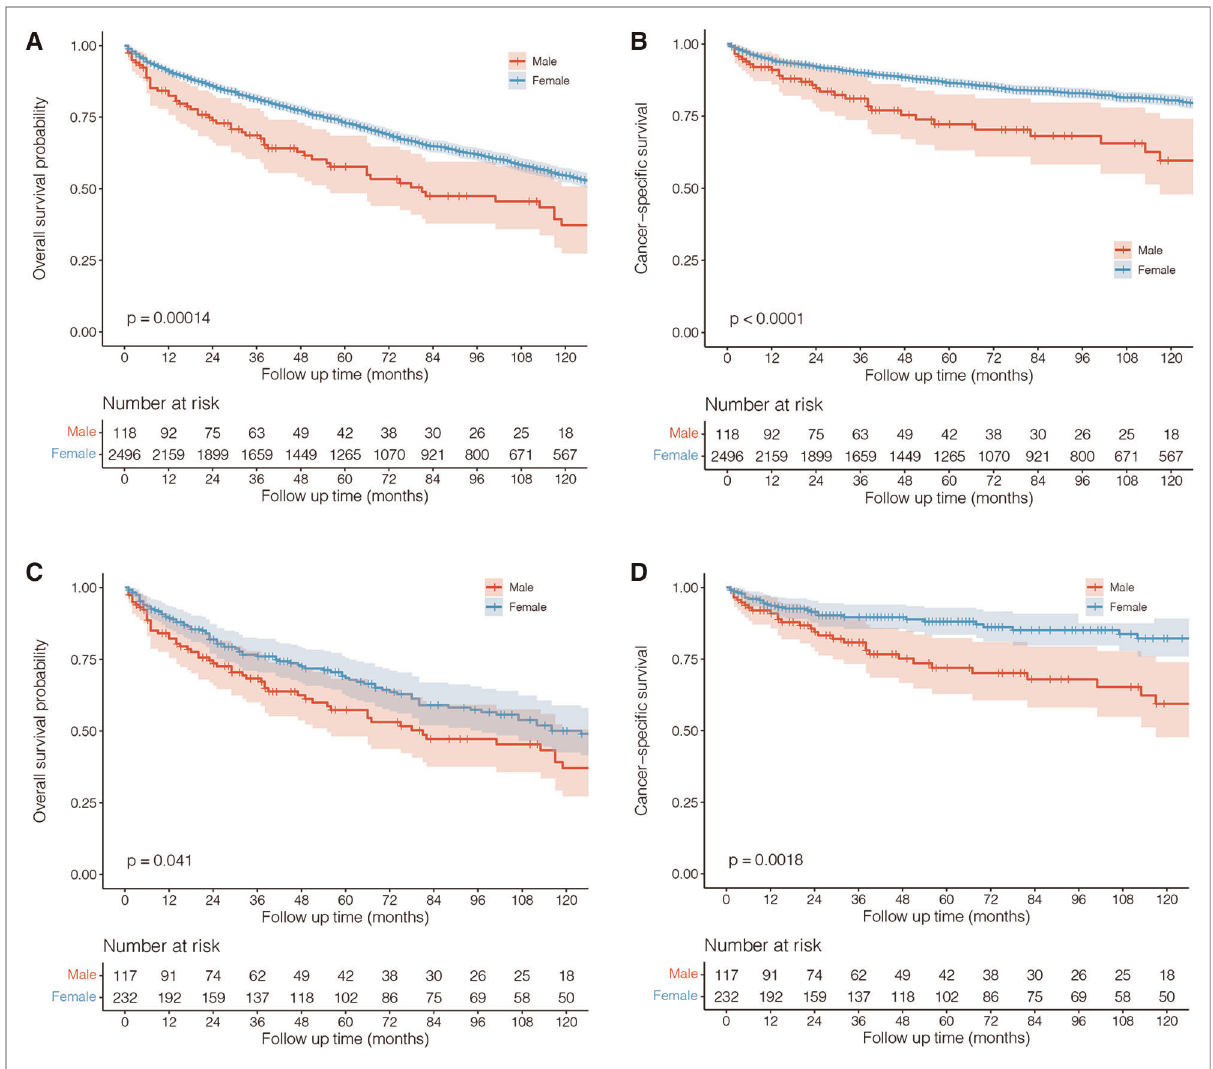
FIGURE 2 Kaplan – Meier survival curves and log-rank tests for male and female patients with primary breast lymphoma. ( A and B ) Before propensity scoring matching (PSM). ( C and D ) After